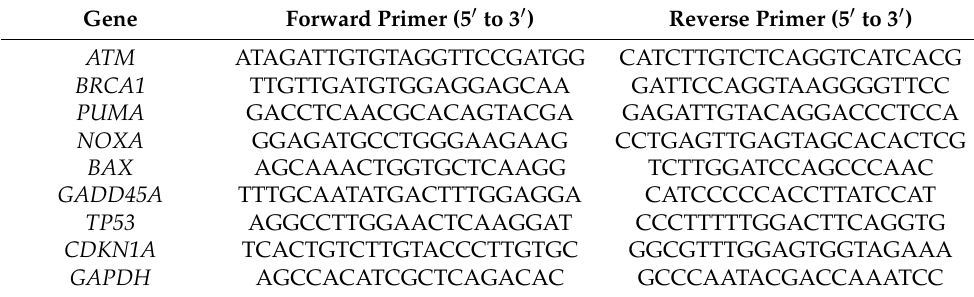
Table 1. Primer sequences for quantitative